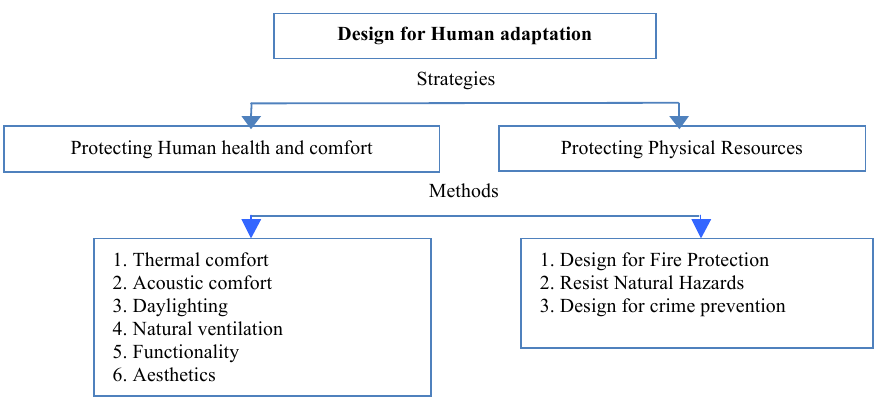
Figure 5. Strategies and Methods to achieve human